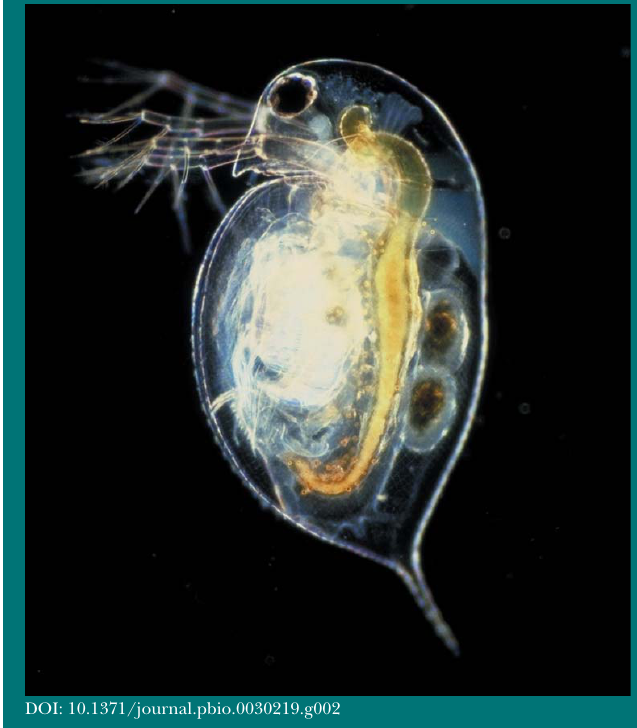
Figure 2. Daphnia pulex , a Species Waiting in the Wings to Achieve “Model” Status (Photo: Paul Hebert)